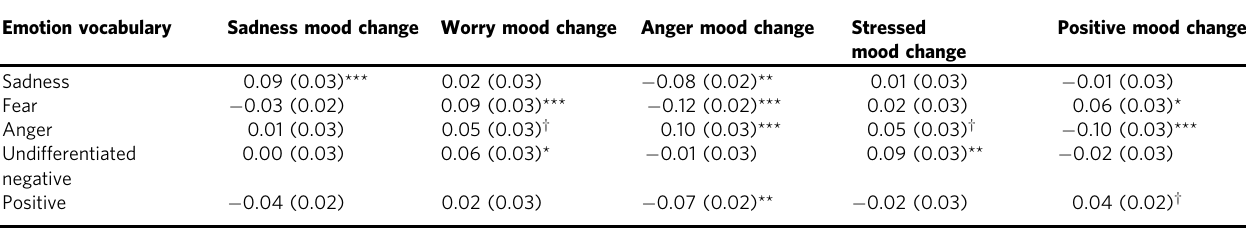
Table 2 Partial correlations between emotion vocabulary (EV) for distinct emotion types and changes in self-rated moods in study 1 ( N =